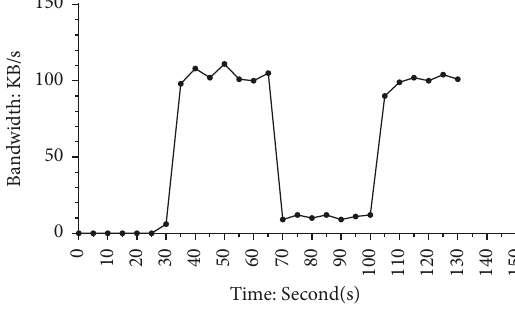
Figure 3: Upload bandwidth